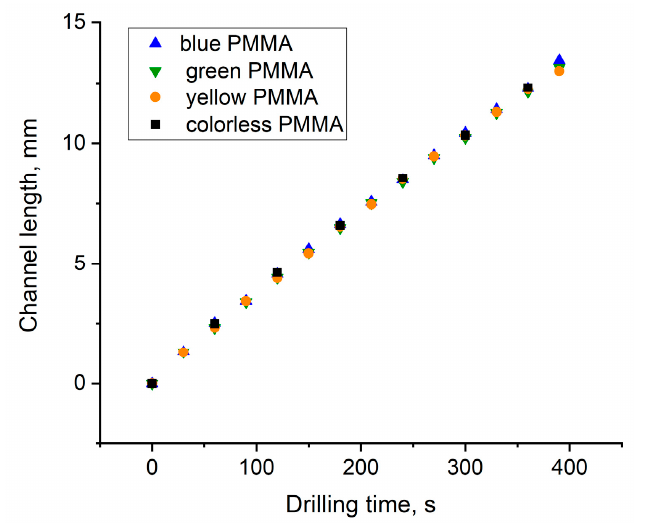
Figure 8. Channel length z vs. drilling time t for colorless and dyed PMMA samples at 10 Hz rep rate before saturation.